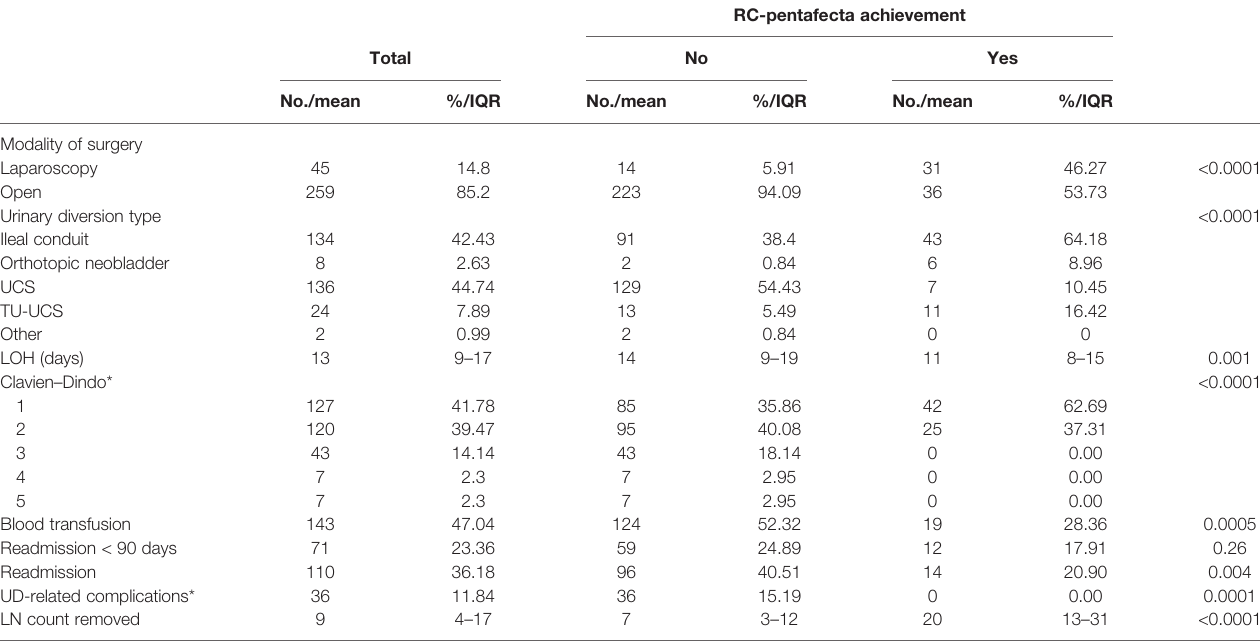
TABLE 3 | Radical cystectomy details and perioperative outcomes in patients who achieved or not